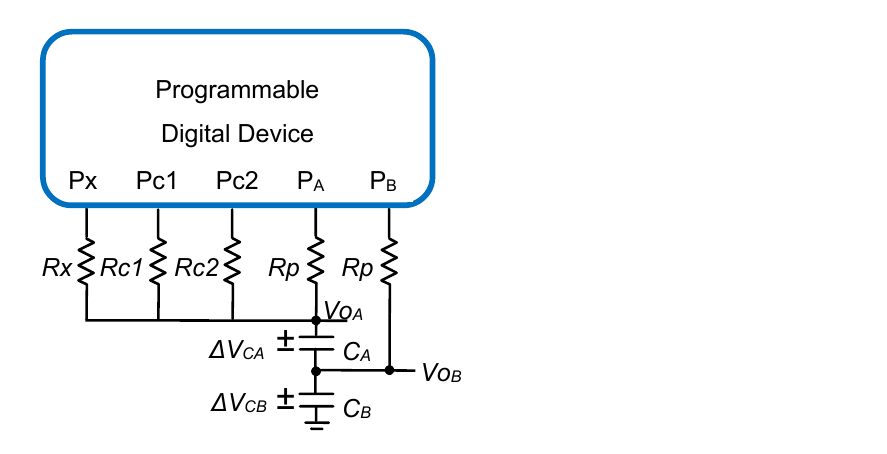
Figure 3. The two-capacitor direct interface circuit (TCDIC) proposed in this article. The circuit uses two capacitors, C A and C B , replacing C in Figure 1. The pins, P A and P B , measure the times needed to estimate Rx .